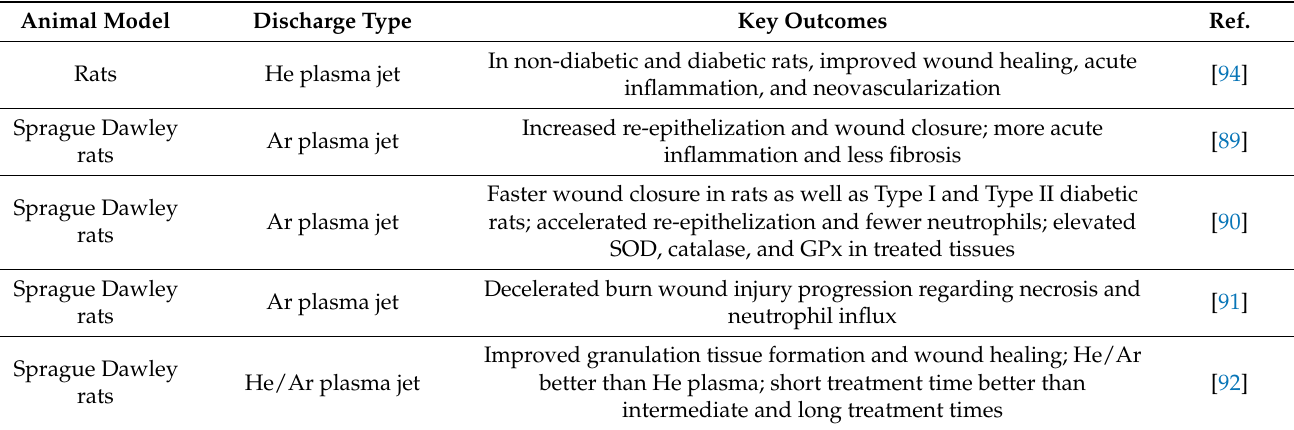
Table 2. Study overview on gas plasma-treated skin and wound healing in medium-sized rodents (rats, rabbits). Animal Model Key Outcomes